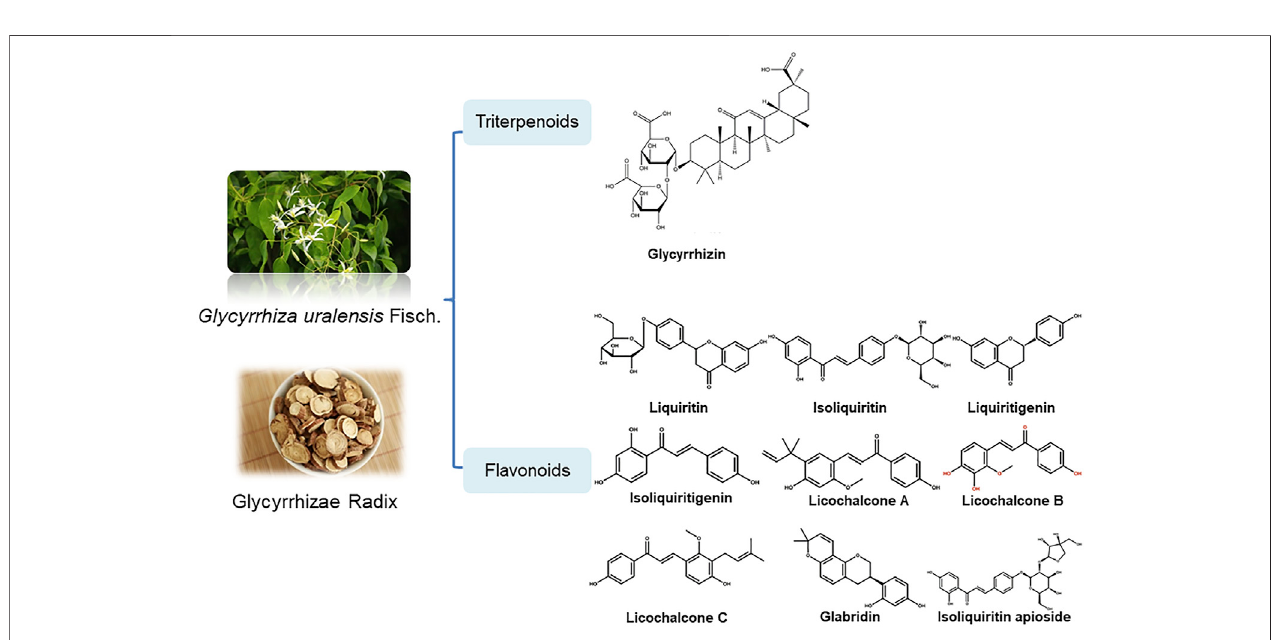
FIGURE 1 | Structural formula of potential components of